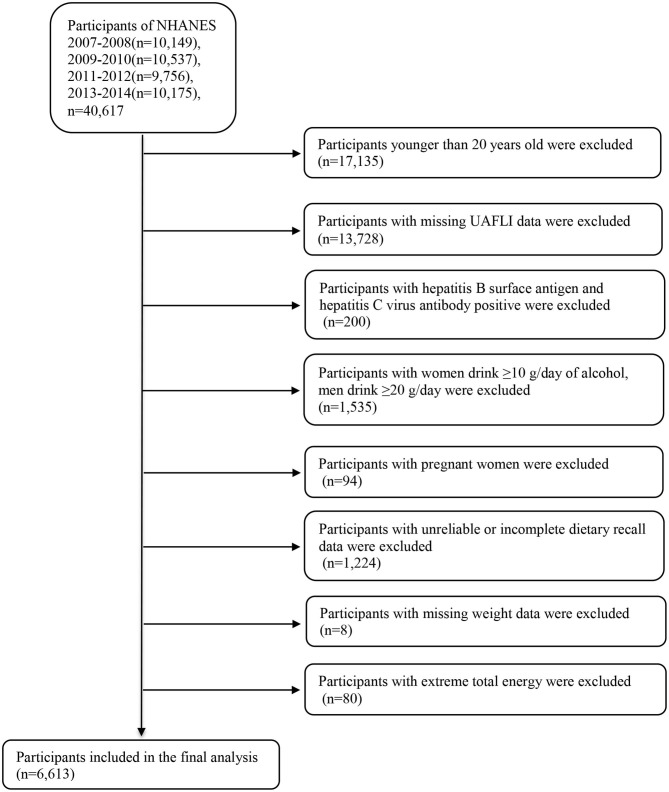
Flow chart of the selection process. NHANES, National Health and Nutrition Examination Survey.